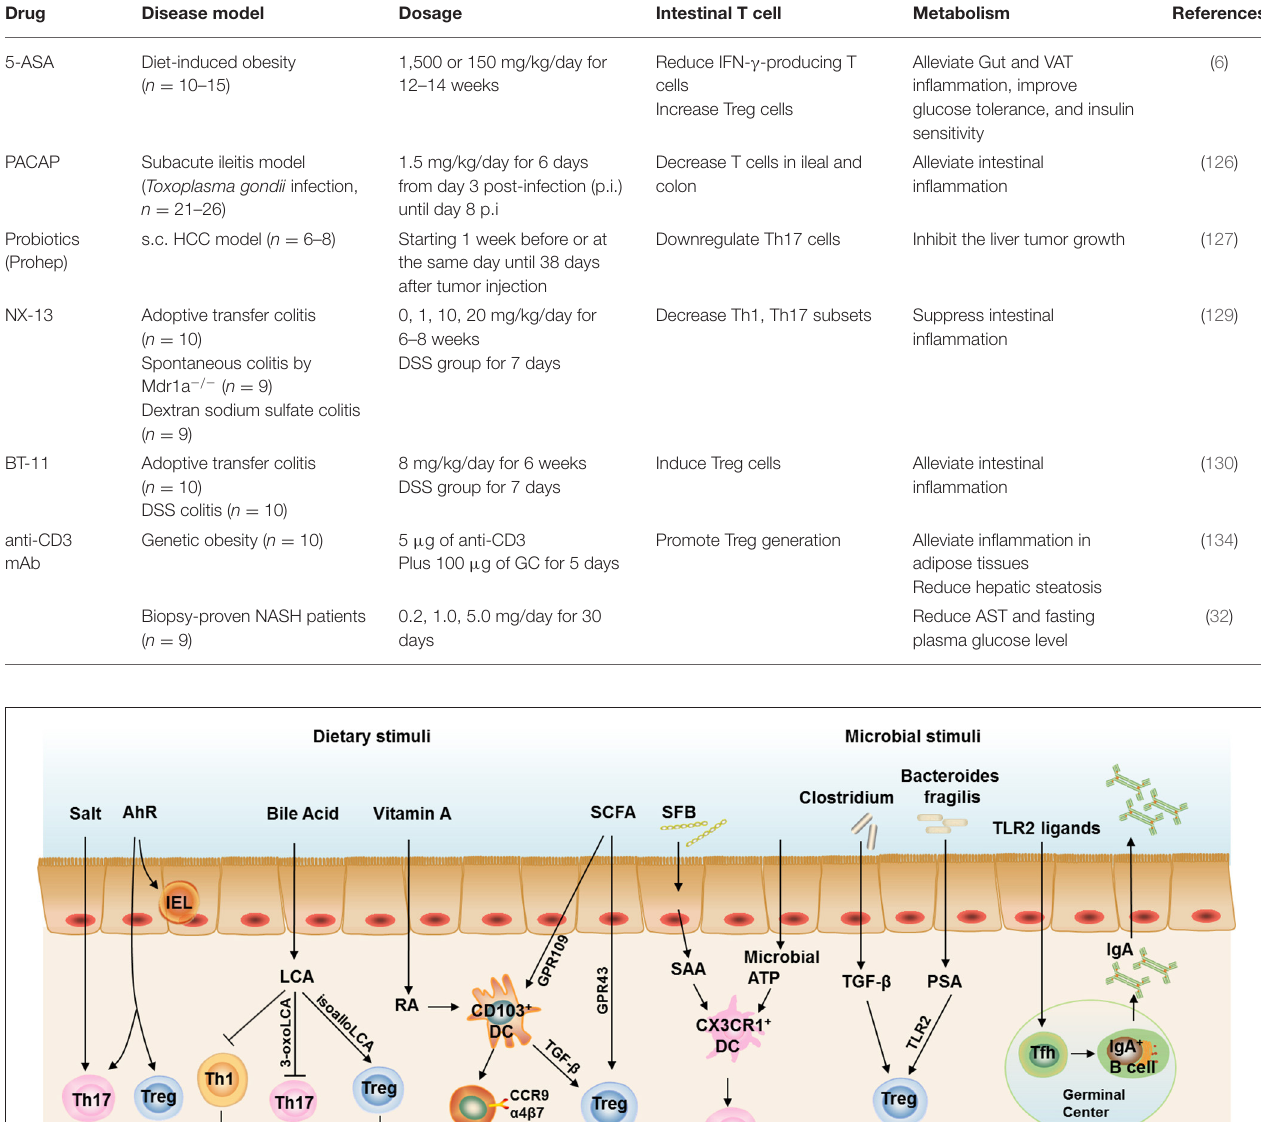
TABLE 1 | Drugs targeting intestinal T cells in treating obesity and its related complications. Drug